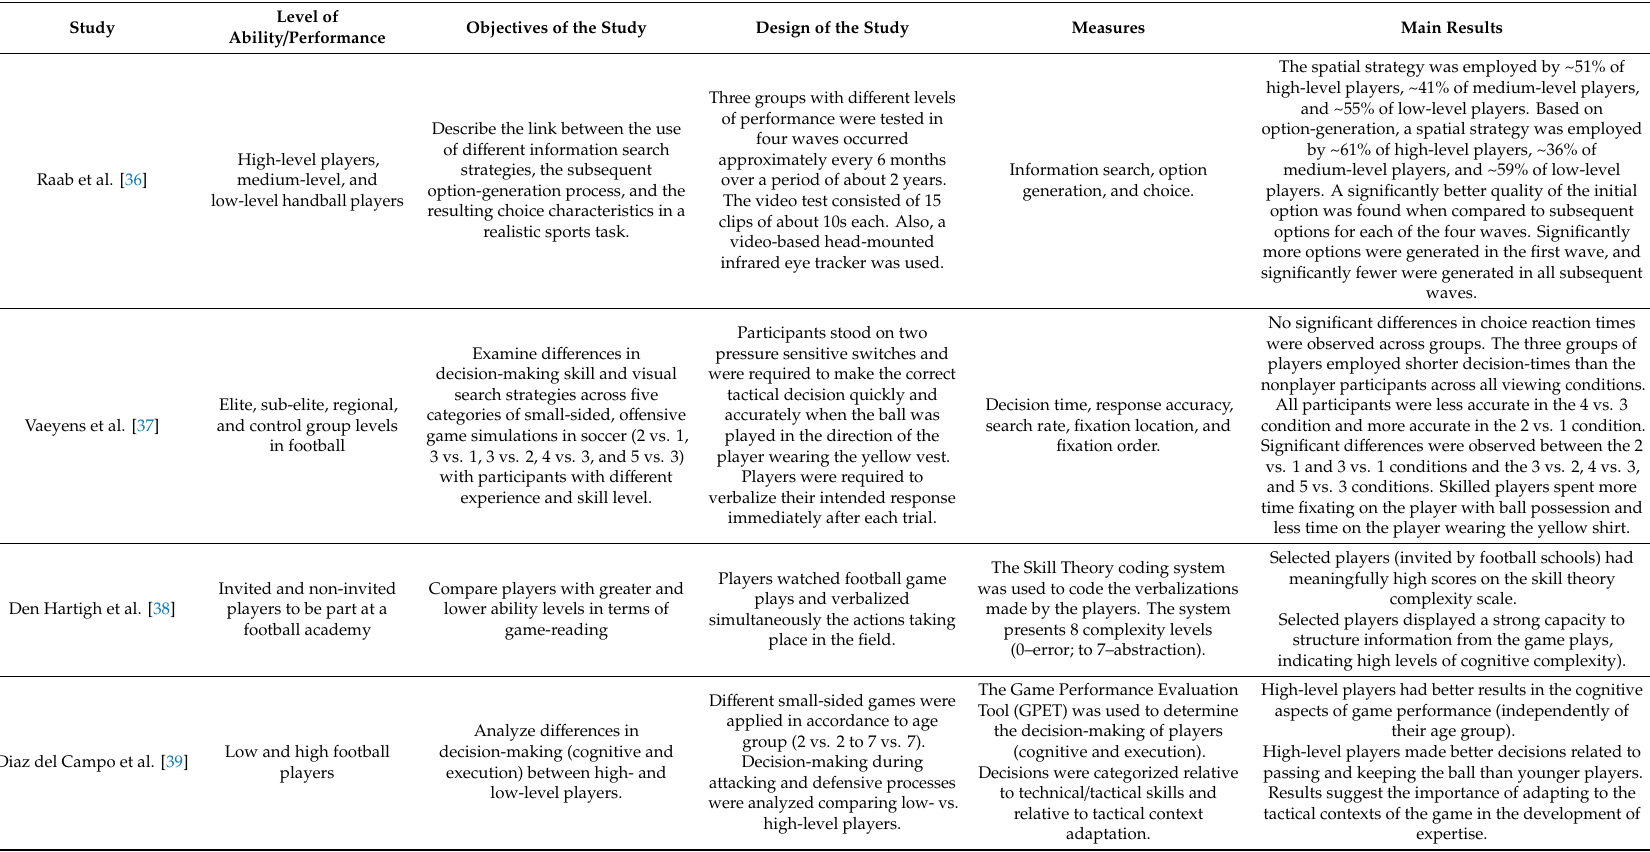
Table 2. Studies that compared the decision-making processes between low- and high-ability levels in youth team-sports